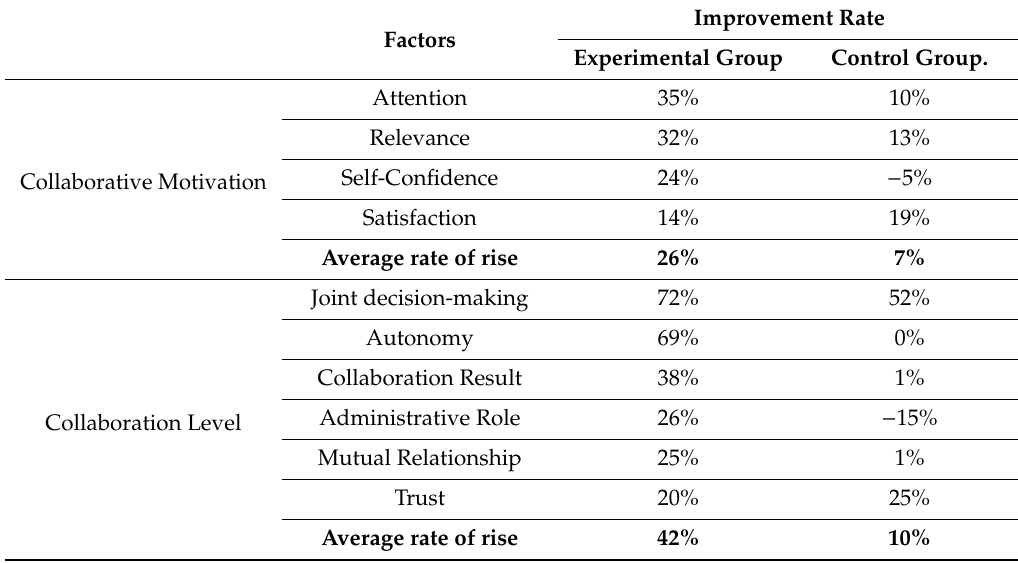
Table 15. Pre-score and post-score improvement rates of collaboration between experimental and control groups.